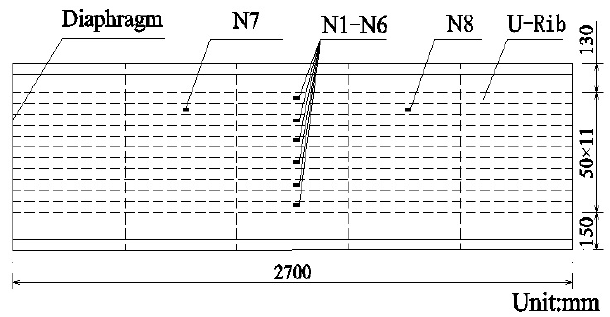
Figure 15. The layout of the strain measurement points.